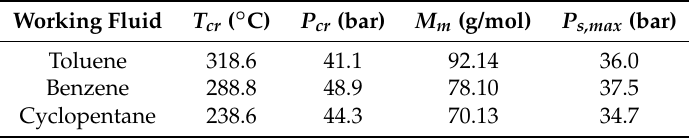
Table 1. Thermodynamic properties of selected working